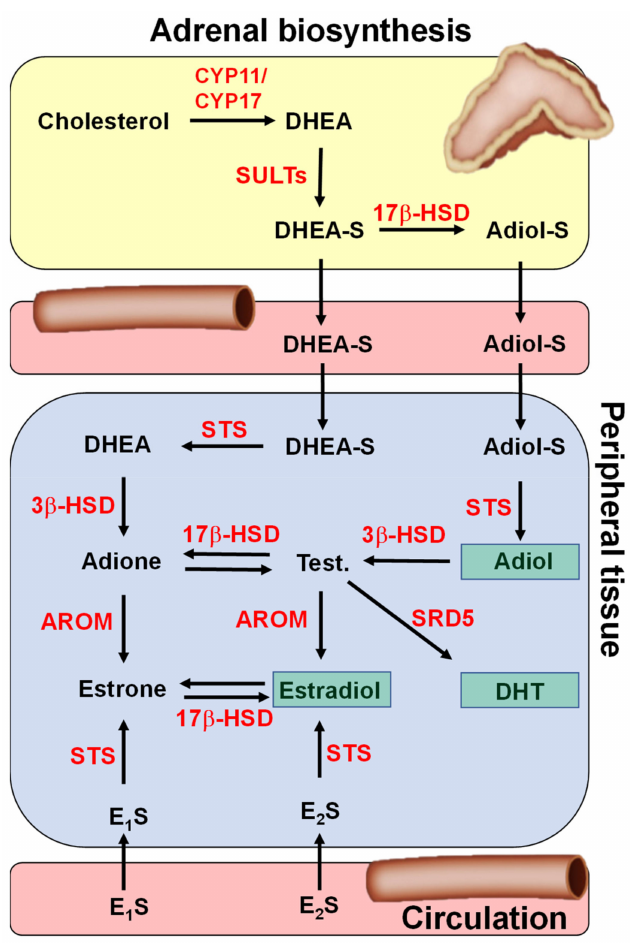
Figure 1. Synthesis pathways for steroids with oestrogenic and androgenic properties. Sex steroid pre- cursors, such as dehydroepiandrosterone sulphate (DHEA-S) and androstenediol sulphate (Adiol-S), are synthesised in the adrenal gland from cholesterol. The sulphate group increases water solubility, allowing them to be more readily transported in the blood. Once at target peripheral tissue, sulphated sex steroids are taken up via organic anion transporting polypeptides (not shown). Steroid sulphatase hydrolysis these sulphated steroids, allowing them to act either at oestrogen or androgen